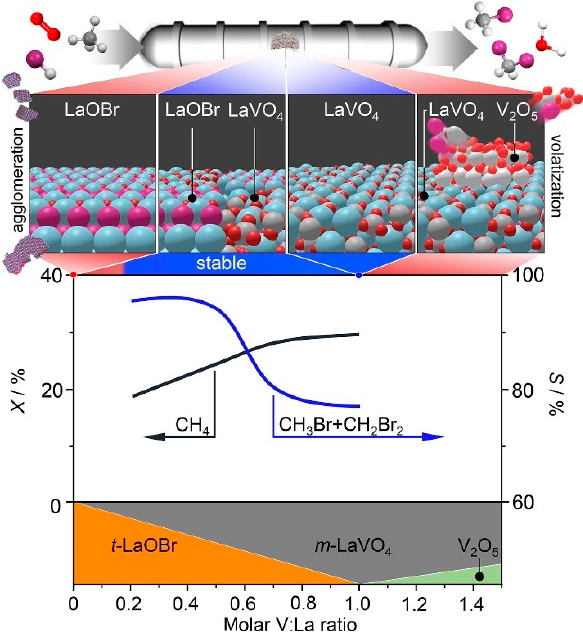
Figure 2. Structure–performance relationships of LaV x O 2.5x+1.5 catalysts in methane oxybromination as a function of the molar V:La ratio. Obtained with permission from [50].